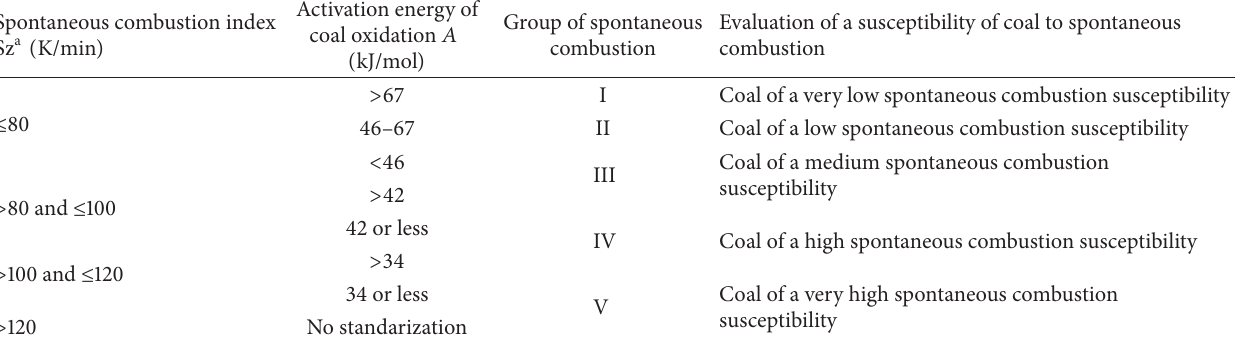
Table 1: Classification of coal by a susceptibility of spontaneous combustion.